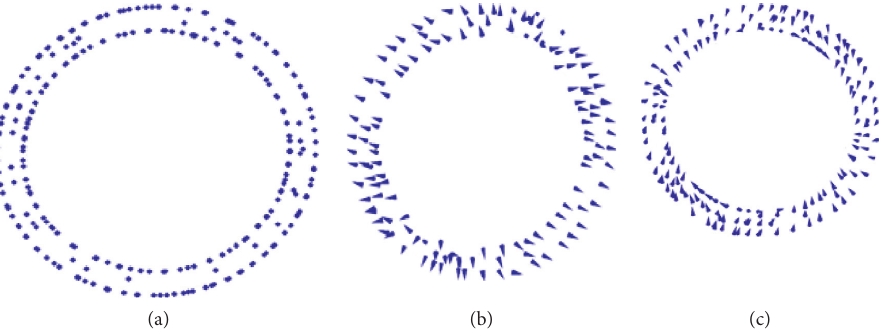
Figure 8: Metal flowing in an instantaneous at the same location: (a) before rolling, (b) during rolling, and (c) after